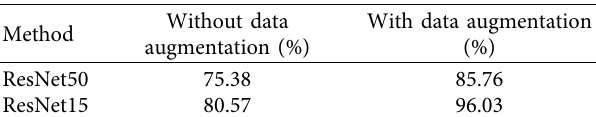
Figure 9: Comparison of accuracy curves. (a) Accuracy curves of ResNet50 and ResNet15 with or without data augmentation. (b) Accuracy curves of ResNet15 with or without residual models. (c) Accuracy curves of different Table 3: Recognition accuracy of two methods with or without data augmentation.